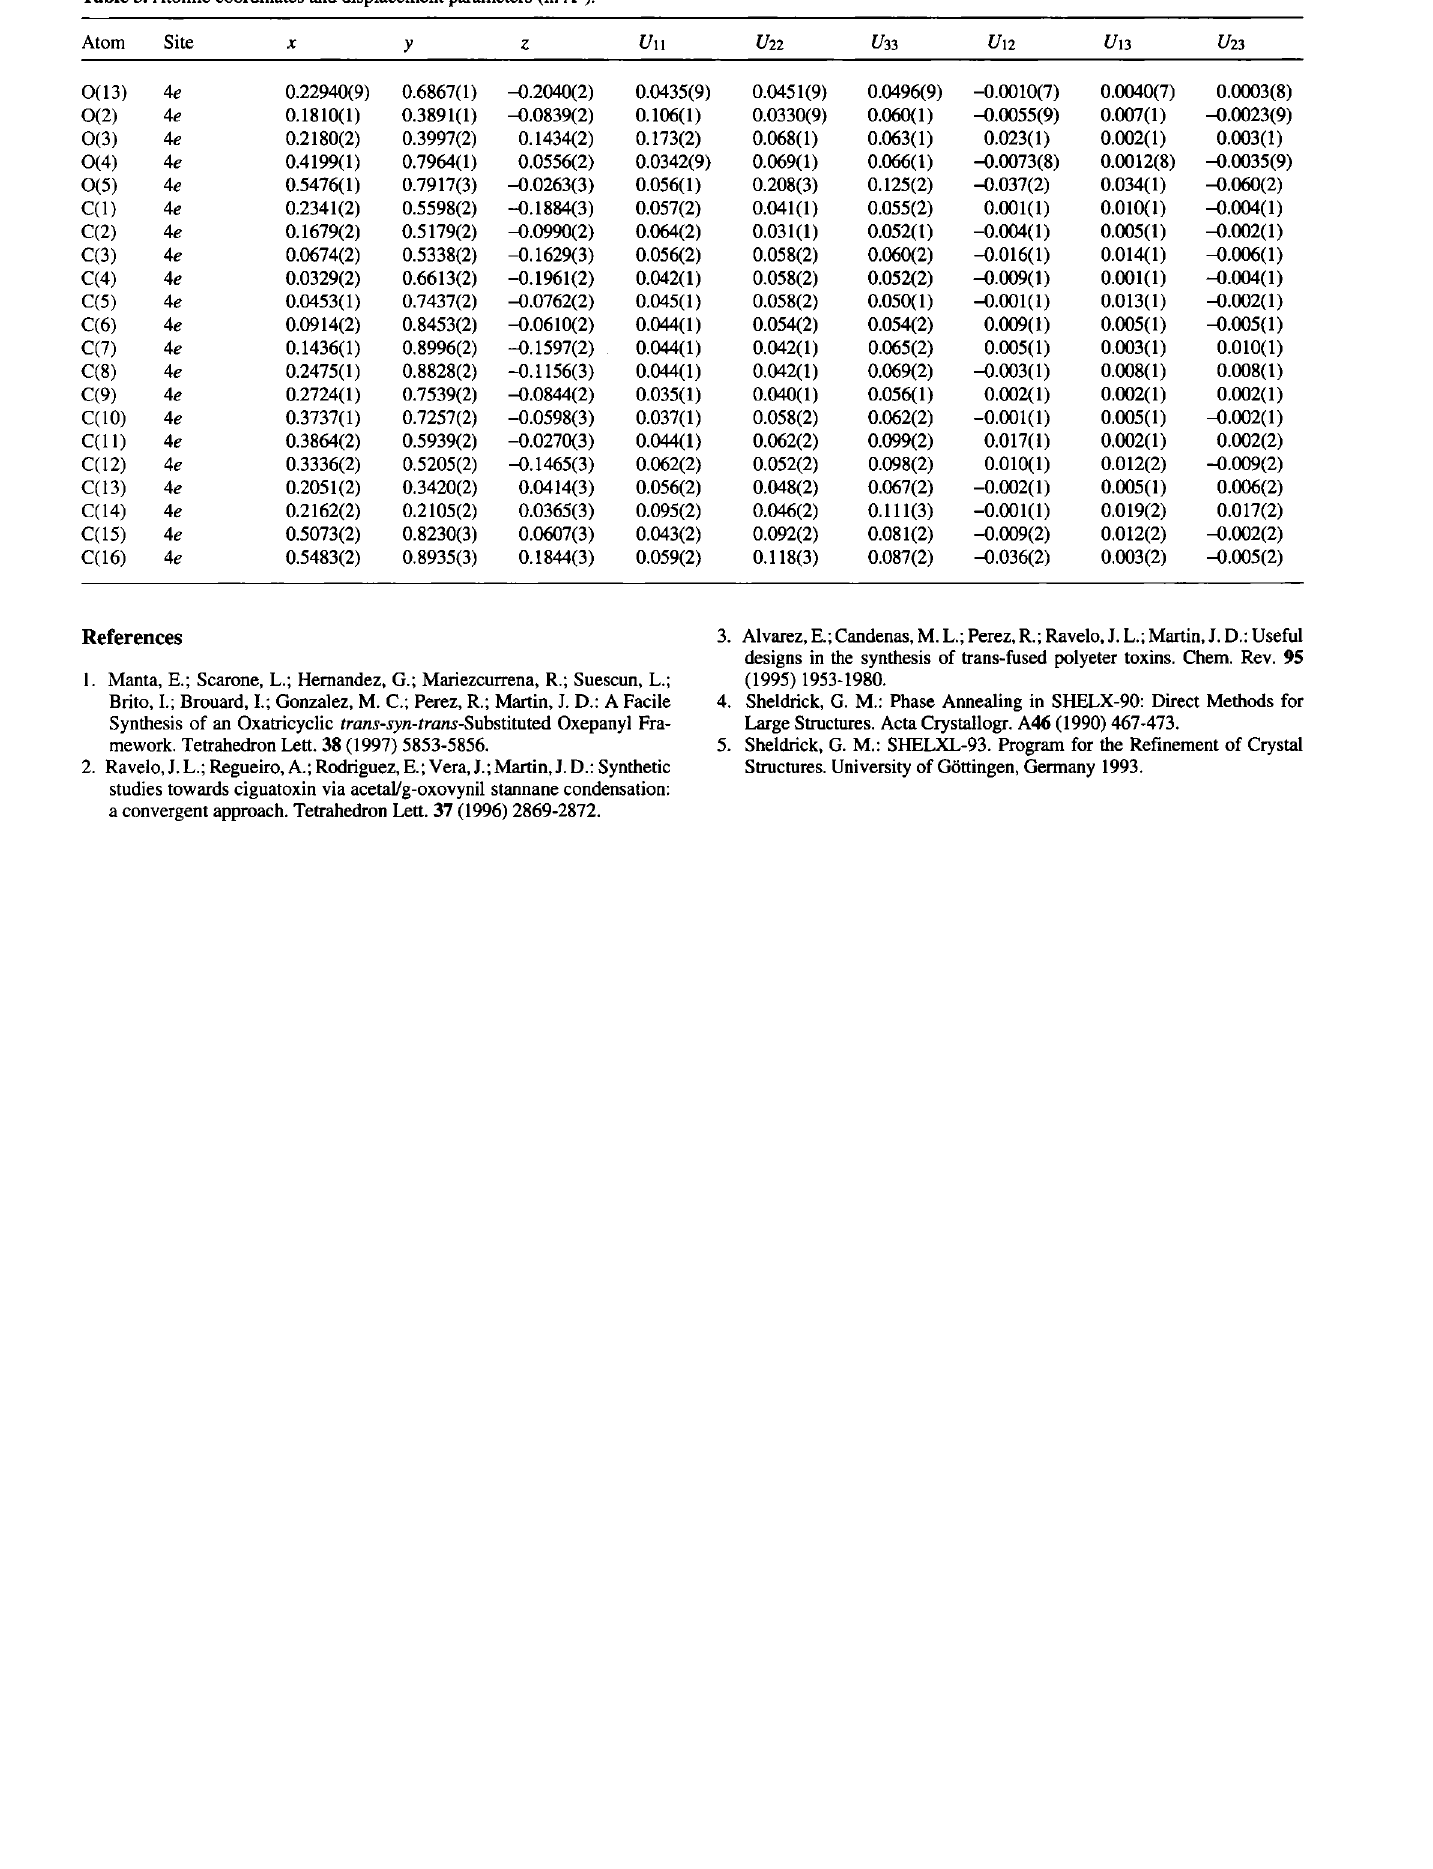
Table 3. Atomic coordinates and displacement parameters (in Â 2